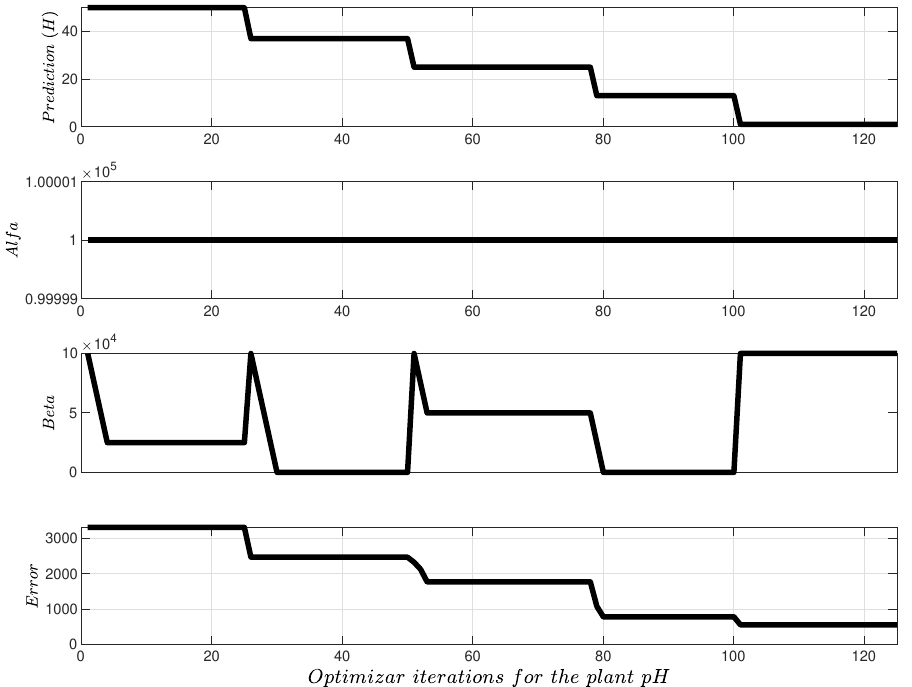
Figure 8. Evolution of tuning parameters P , alpha and beta with algorithm PSM case Alkalinization of sugar cane